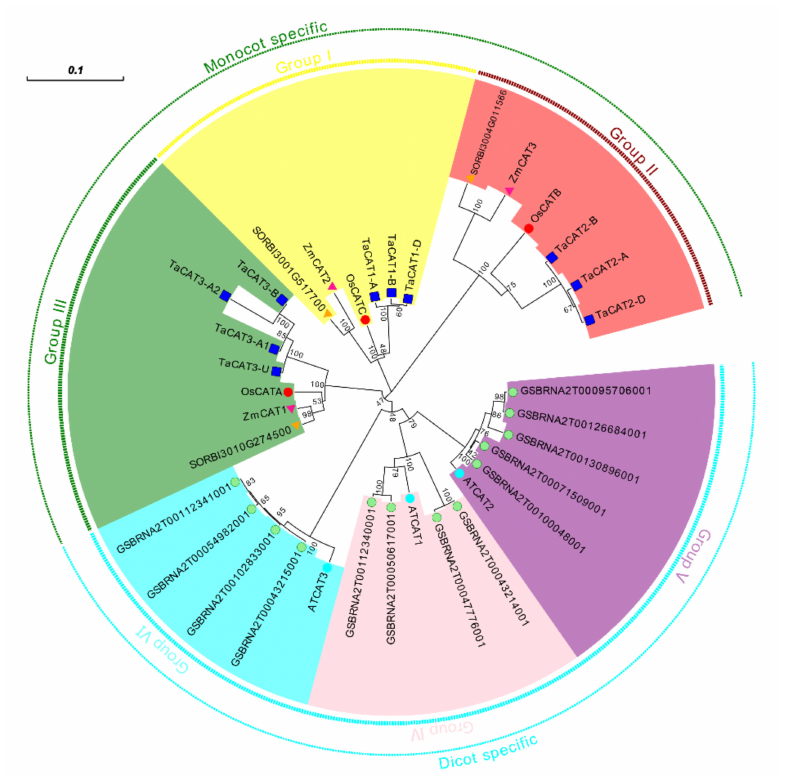
Figure 1. A neighbor-joining (NJ) phylogenetic tree of CATs in wheat ( Triticum aestivum L. Ta), Arabidopsis ( Arabidopsis thaliana L. At), maize ( Zea mays L. Zm), rice ( Oryza sativa L. Os), sorghum ( Sorghum bicolor L.), and B. napus ( Brassica napus L.). The tree was generated with the full-length CAT protein sequences of wheat (blue box), rice (red circle), Arabidopsis (cyan circle), maize (pink triangle), sorghum (yellow triangle), and B. napus (green circle). The phylogenetic tree showed six major phylogenetic groups and were indicated with different coloured backgrounds. Scale: